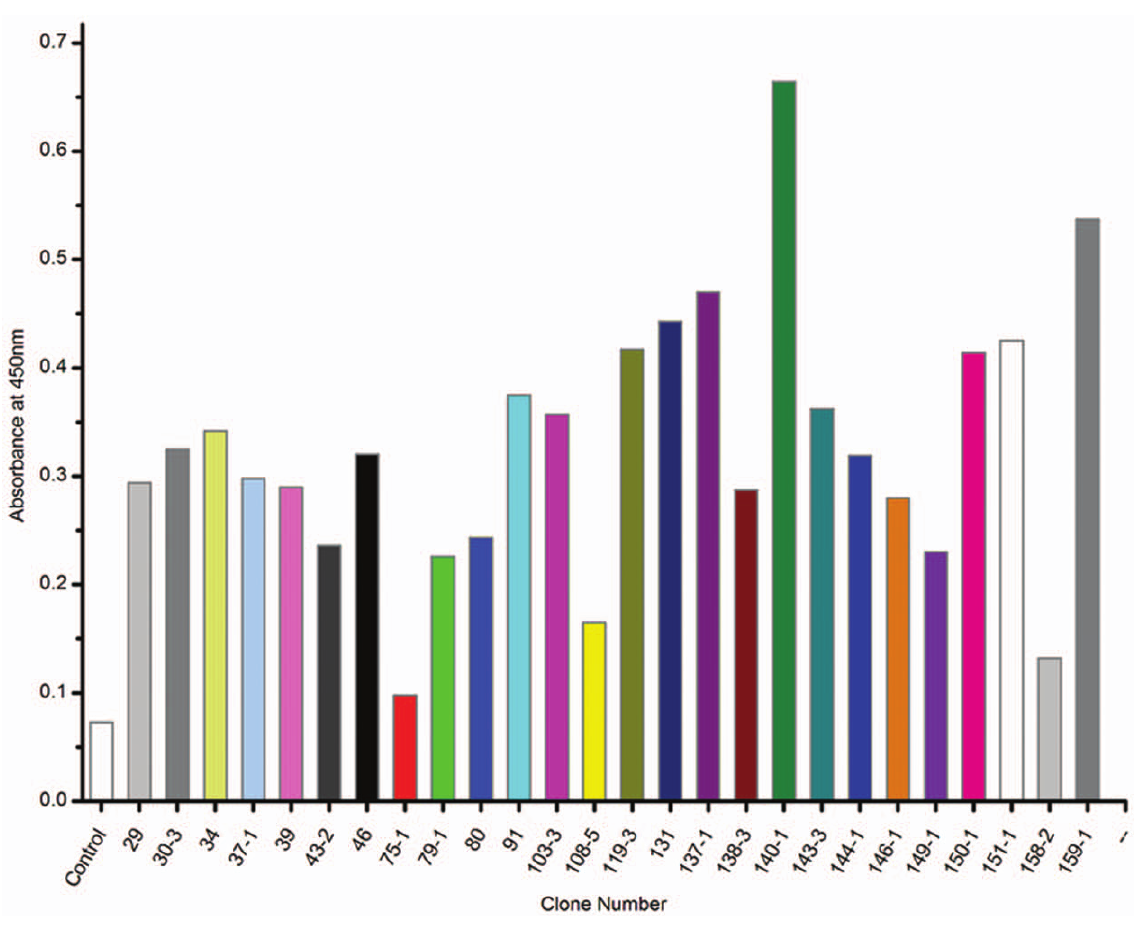
Figure 5. Binding activity of soluble scFvs to DES-OVA by indirect ELISA. The background (using wells coated with OVA) was subtracted from the absorbance of each DES conjugate. Control was the supernatant of the E. coli BL21 (DE3) without scFv gene.